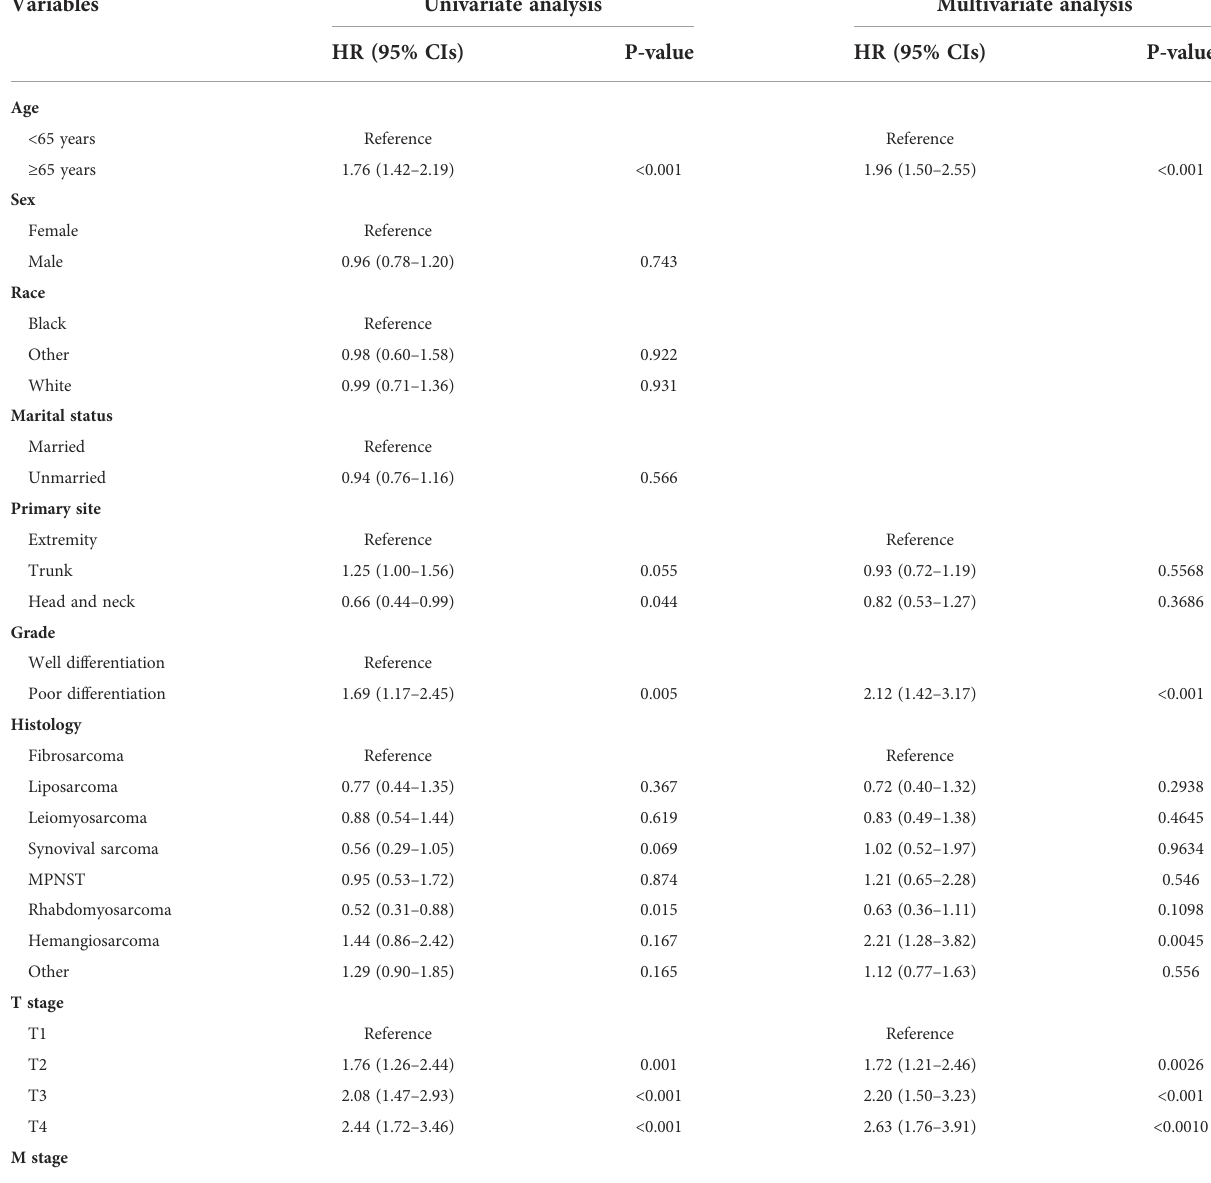
TABLE 5 Univariate and multivariate Cox regression analysis for identi fi cation independent prognostic factors for overall survival in patients with soft tissue sarcoma with lymph node